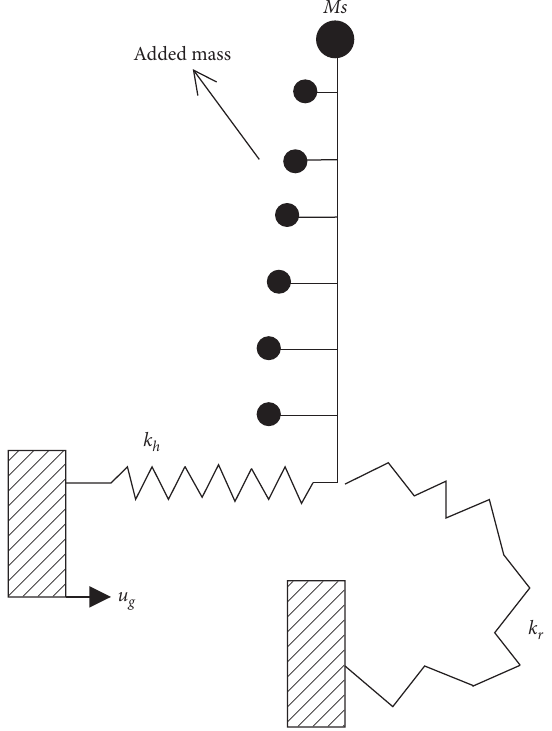
Figure 3: Simplified model of the fluid-cylinder-soil